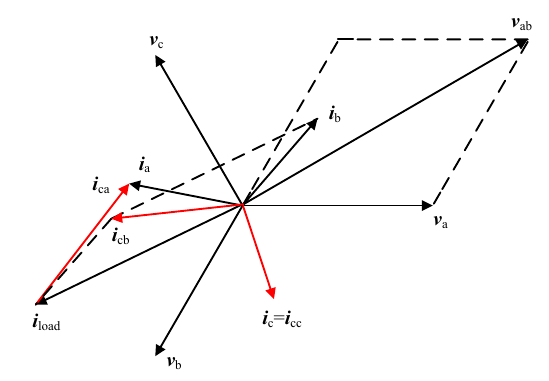
Fig. 8 Phasor diagram under RB